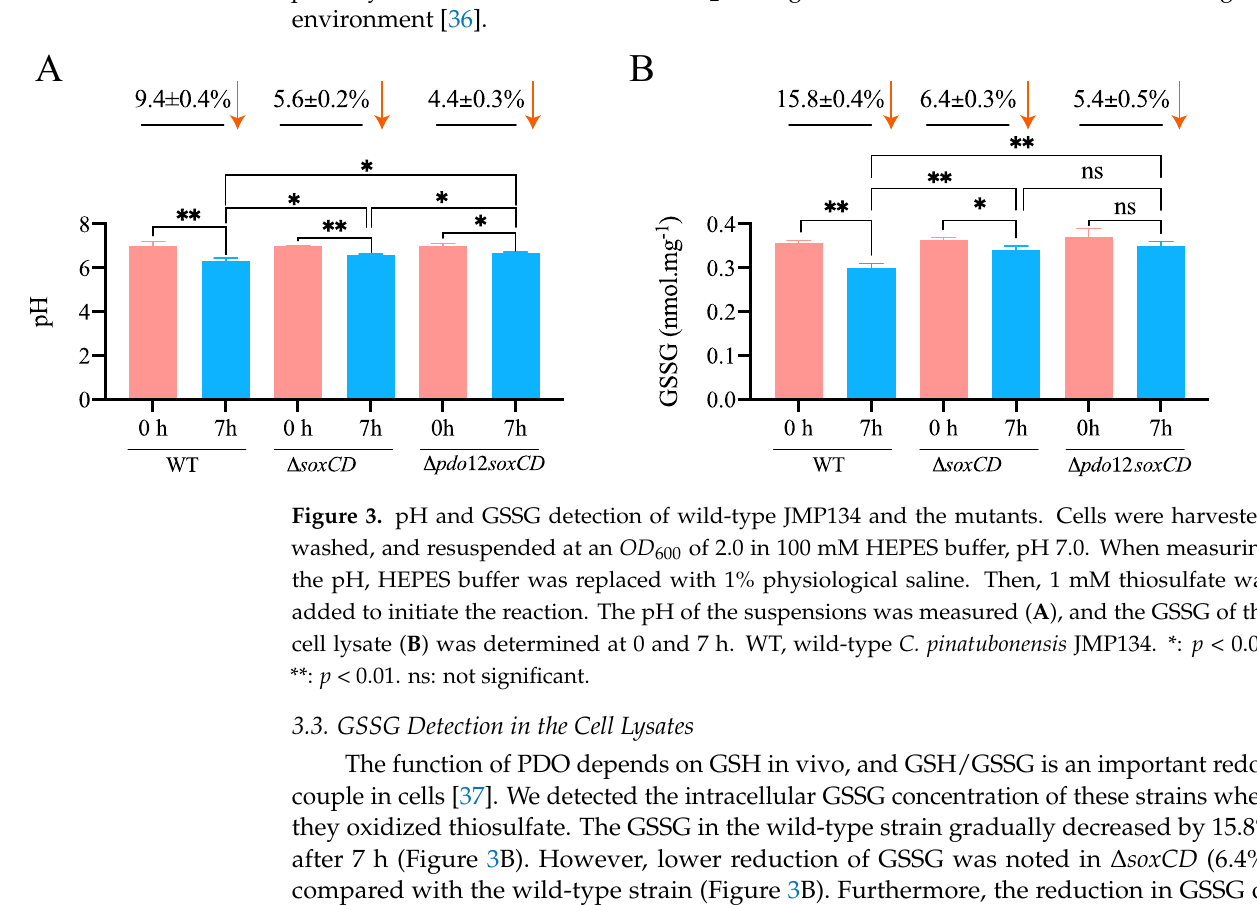
Figure 2. Thiosulfate oxidation by wild-type JMP134 and its mutants. Cells of C. pinatubonensis JMP134, Δ soxCD , Δ pdo12soxCD , and Δ pdo12 were harvested, washed, and resuspended at an OD 600 of 2.0 in 100 mM HEPES buffer, pH 7.0. Then, 1 mM thiosulfate was added to initiate the reaction. Thiosulfate ( A ), sulfane sulfur ( B ), sulfate ( C ), H 2 S gas ( D ), and dissolved sulfide ( E ) were deter- mined at different time points. Except for the H 2 S gas values, all data are the average of at least three samples with SD (error bar).